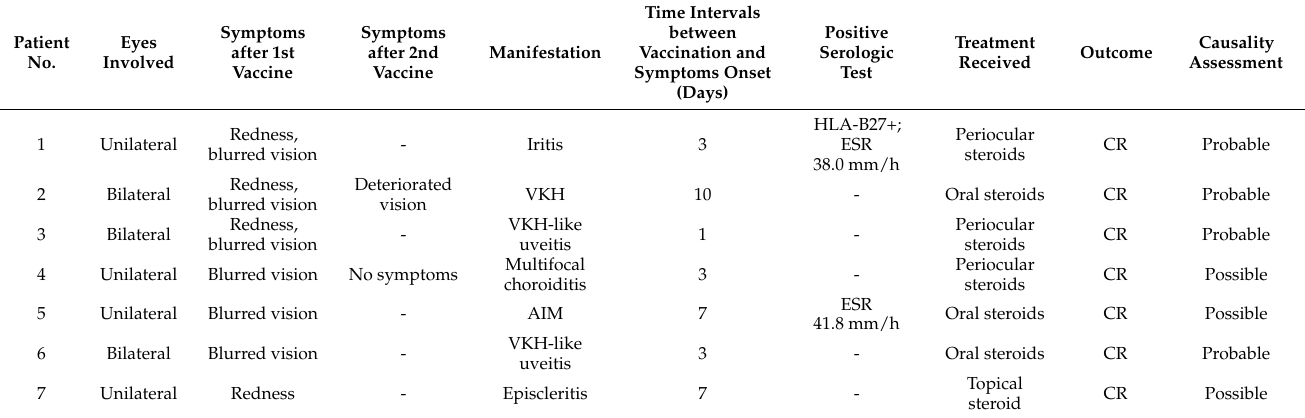
Table 2. Ocular disease after receiving the inactivated COVID-19